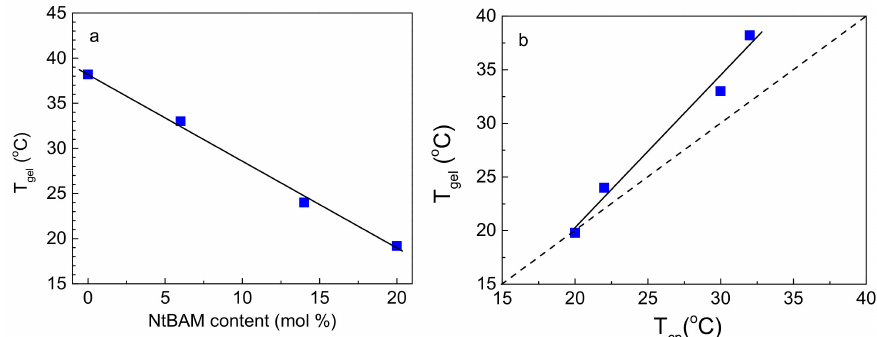
Figure 3. ( a ) T gel as a function of NtBAM content (mol %) of the grafting chains; the straight line is a linear fit of the data (R 2 = 0.993). ( b ) T gel of the graft copolymer versus T cp of the grafting chains. The dashed line denotes T gel = T cp, and the solid line is a linear fit of the data (R 2 = 0.973).